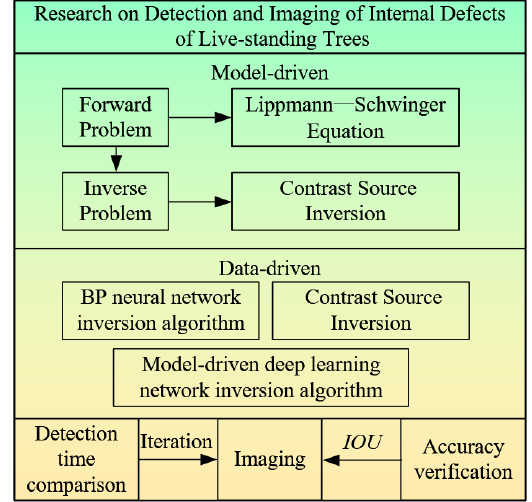
Figure 1. The workflow chart of this paper.